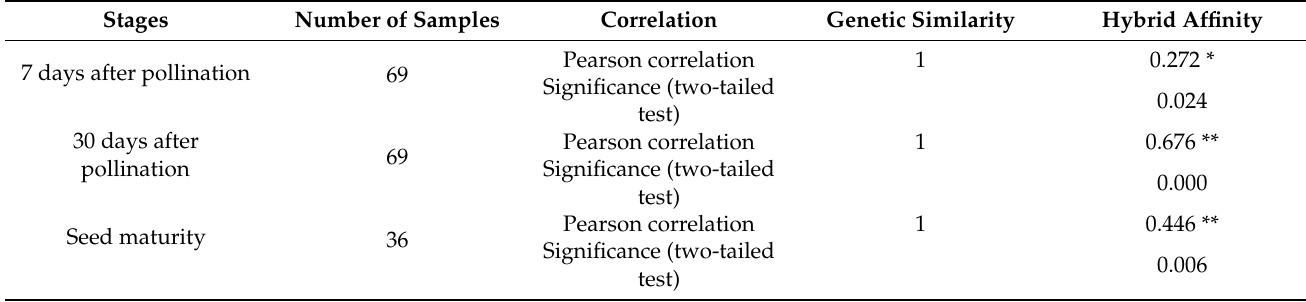
Table 3. Correlation of the genetic similarity and mating affinity of the male and female parents at different stages after